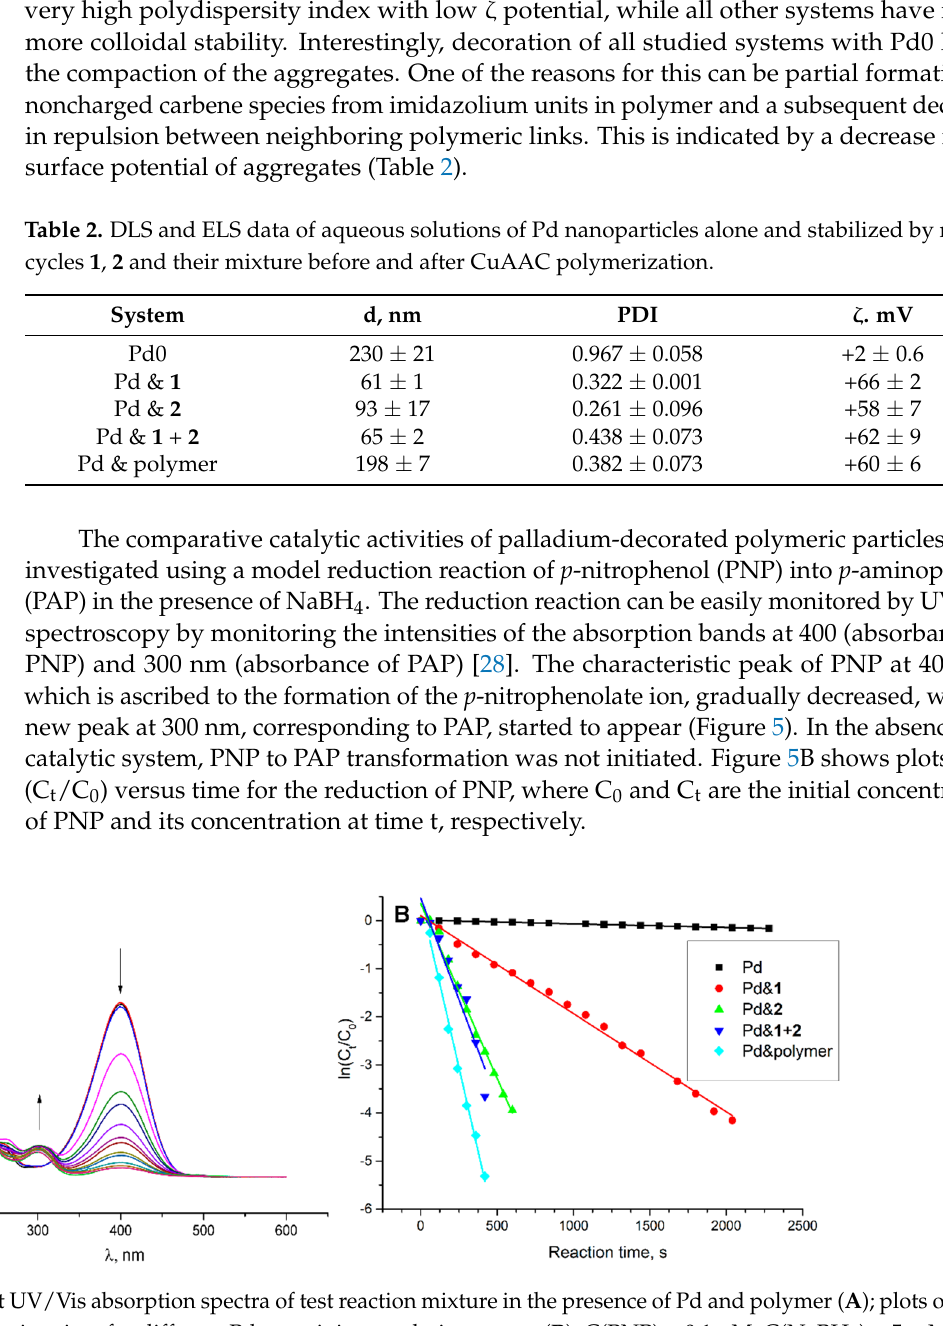
Table 3. Rates of reaction (RC) and specific catalytic activity (SAA) for the reduction in PNP using different catalytic systems.